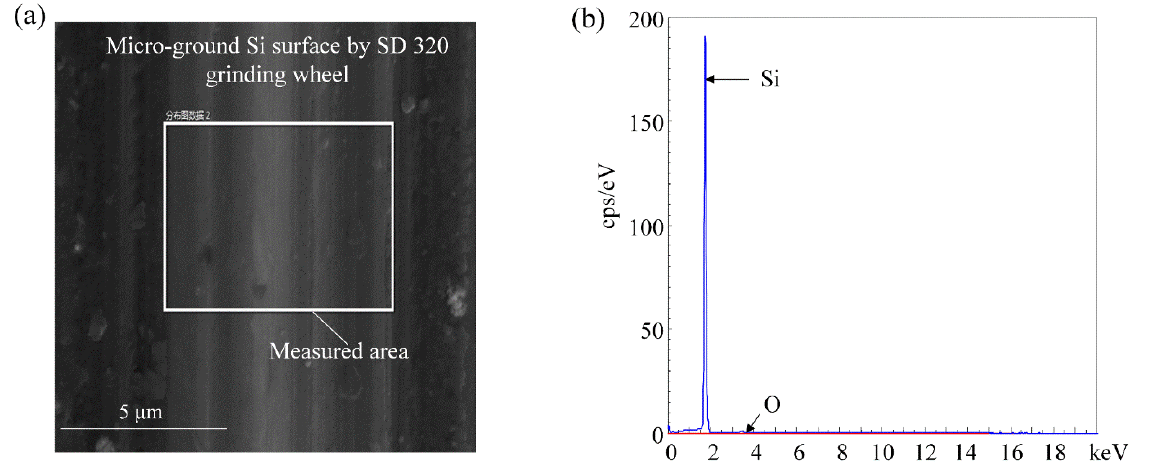
Figure 14. ( a , b )EDS measurement of the microground surface.